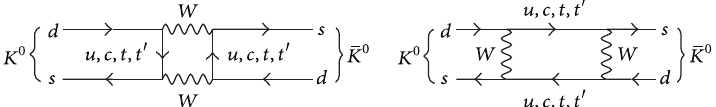
Figure 4: Feynman diagrams for 𝐾 0 mixing with the presence of a VLQ 𝑡 󸀠 in the